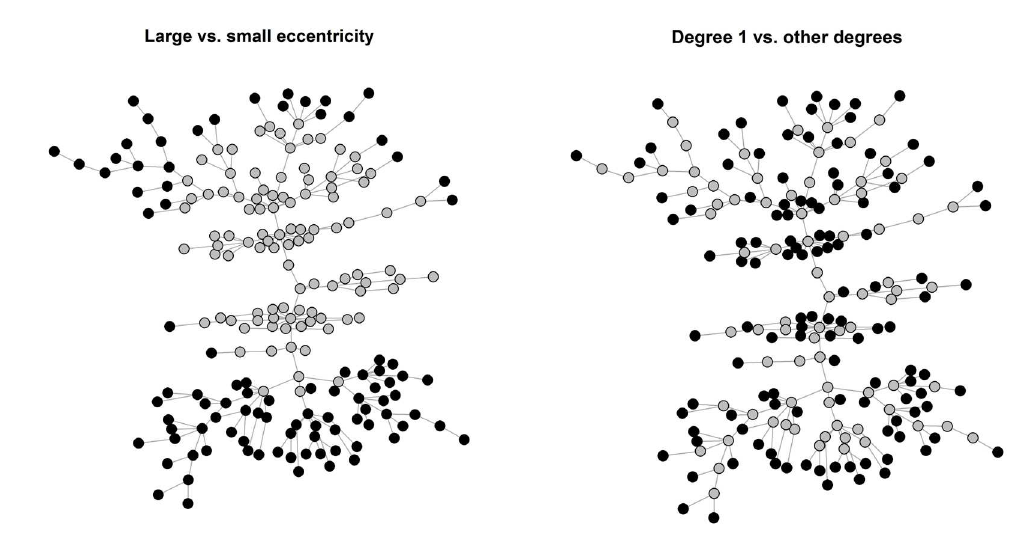
Figure 2. Identification of the central and periphery vertices using eccentricity and